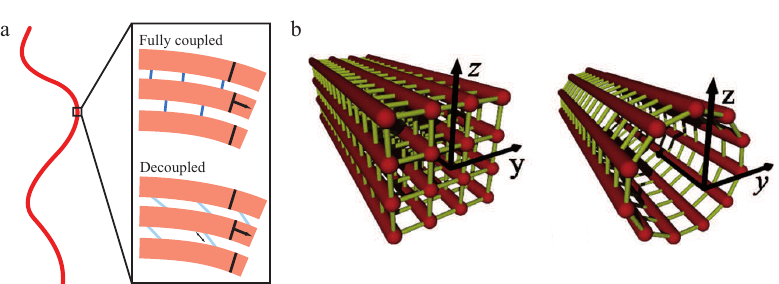
Figure 4. The worm-like bundle (WLB) model. ( a ) A bundle is deformed by in-plane bending, which leads to bending and stretching forces on the internal filaments ( light red ) and shearing of the crosslinkers ( blue ). These three contributions yield the overall Hamiltonian describing the behavior of the bundle. Depending on the mechanical properties of the crosslinker, two limiting cases arise: the fully coupled regime ( dark blue —crosslinkers resist shear deformations) and the decoupled regime ( light blue —crosslinkers deform under shear deformation). The illustration is inspired by Bathe et al. [30]; and ( b ) various bundle geometries can be considered, which yields different scaling predictions for differing bundle cross sections. This figure is adapted from Heussinger et al.